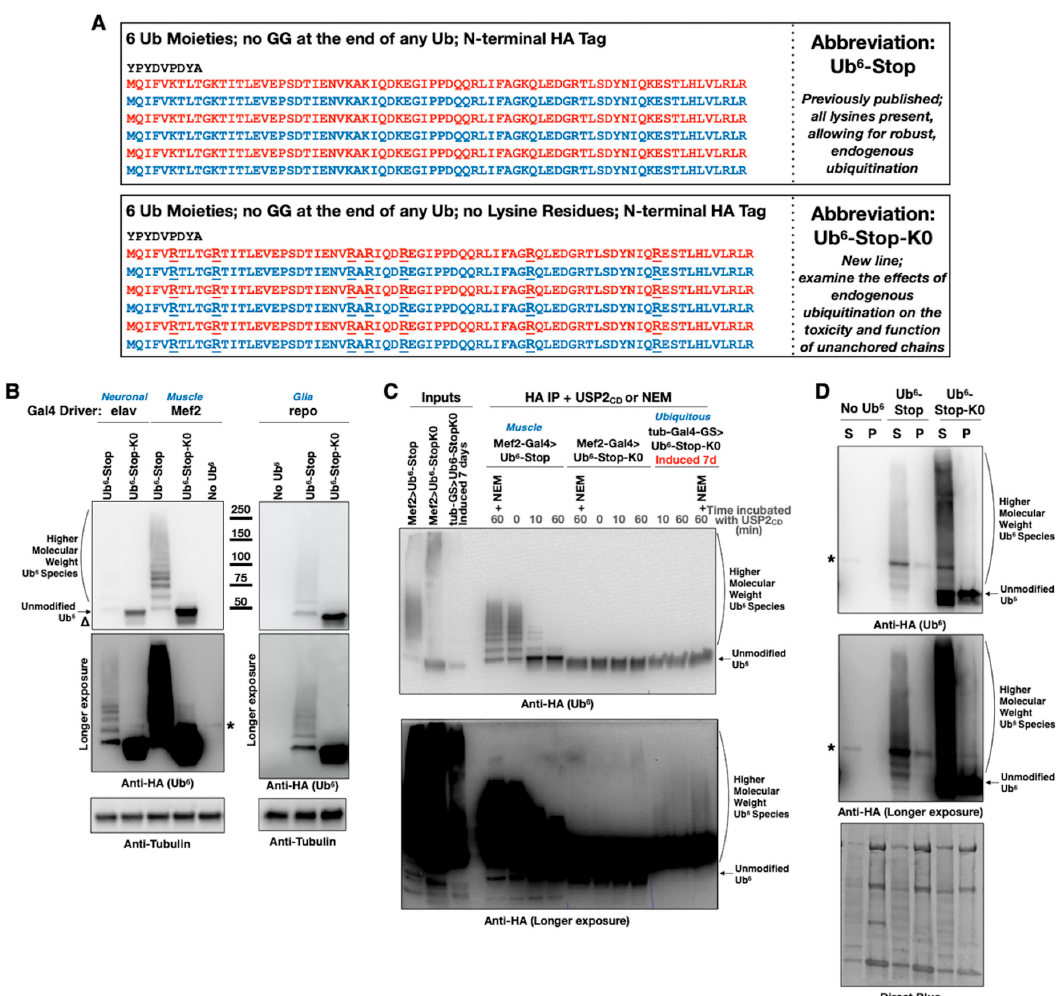
Figure 1. New transgenic Drosophila lines expressing non-cleavable, unanchored ubiquitin chains. ( A ) Amino acid sequence, abbreviation and purpose of HA-tagged ubiquitin chain transgenes. Neither